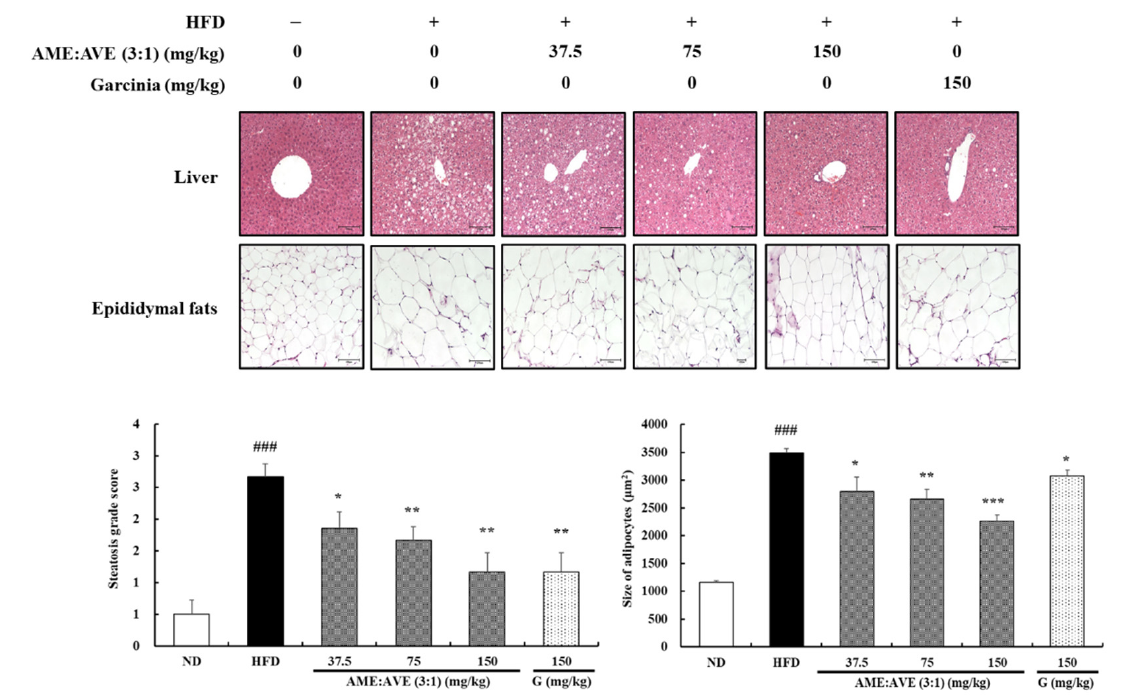
Figure 6. Effects of Atractylodes macrocephala and Amomum villosum extracts (3:1) on liver and epi- didymal fat morphology in high-fat diet-induced obesity in mice. Liver and epididymal adipose tissues were stained with hematoxylin and eosin and observed under a microscope. Steatosis grade scores of liver sections and the size of adipocyte area in epididymal fats were analyzed graphically. Scale bar = 100 μ m. ND, normal-diet group; HFD, high-fat diet group. ### p < 0.001 vs. ND group. * p < 0.05, ** p < 0.01 and *** p < 0.001 vs. HFD group.